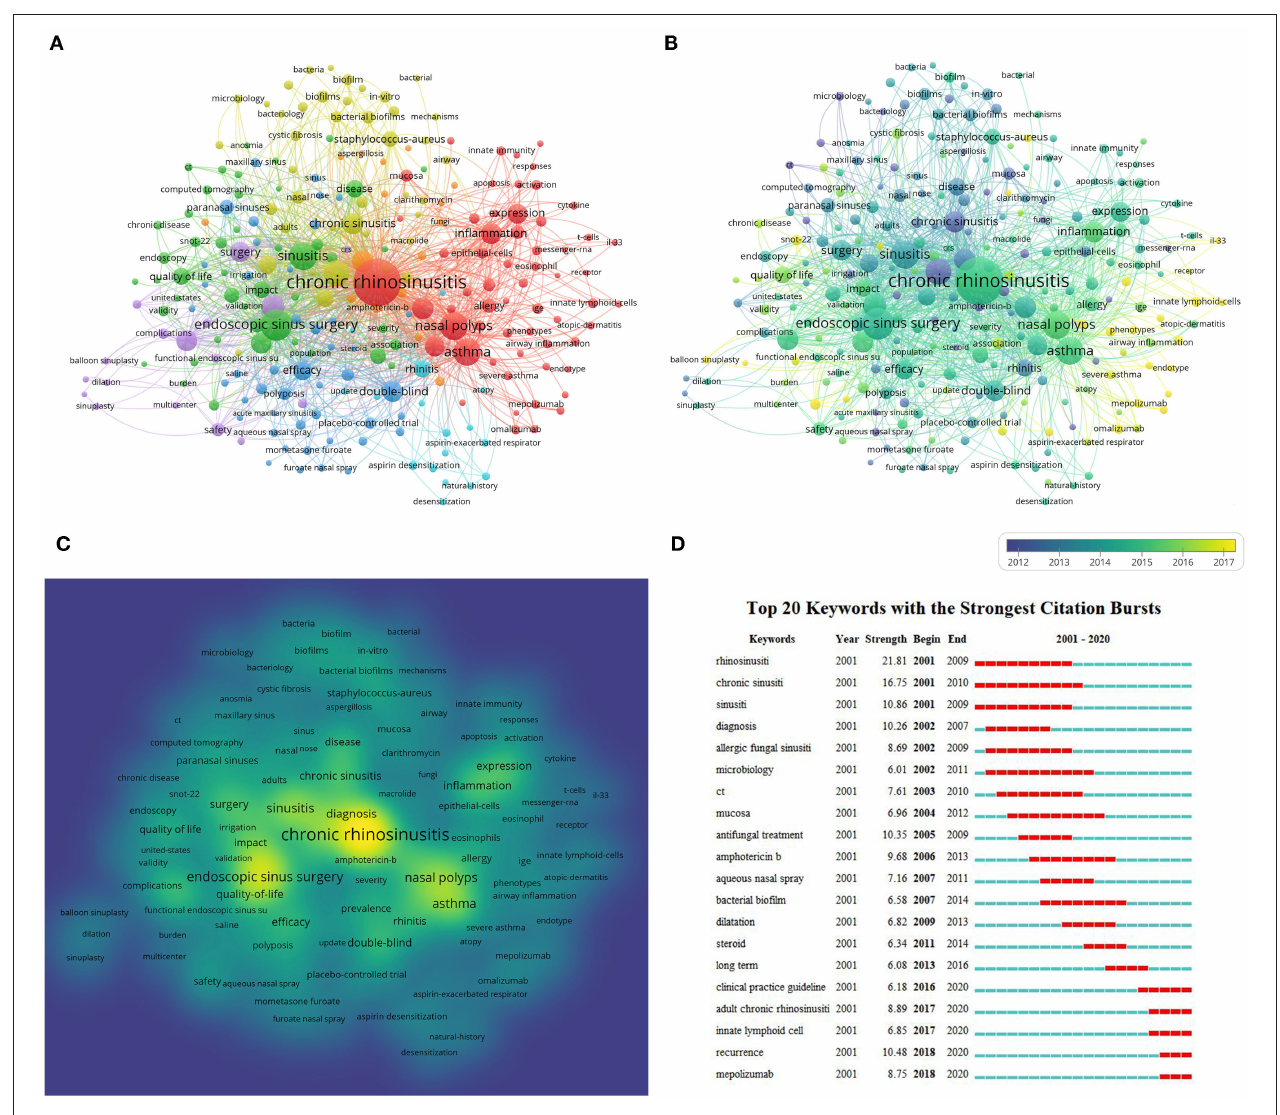
FIGURE 5 | Co-occurrence analysis of global research on CRS treatment based on the WoSCC database from 2001 to 2020. (A) Mapping of keywords in the research field. (B) Distribution of keywords according to the chronological order of appearance. (C) Distribution of keywords according to the mean frequency of appearance. (D) Keywords with the strongest citation bursts in CRS-treatment